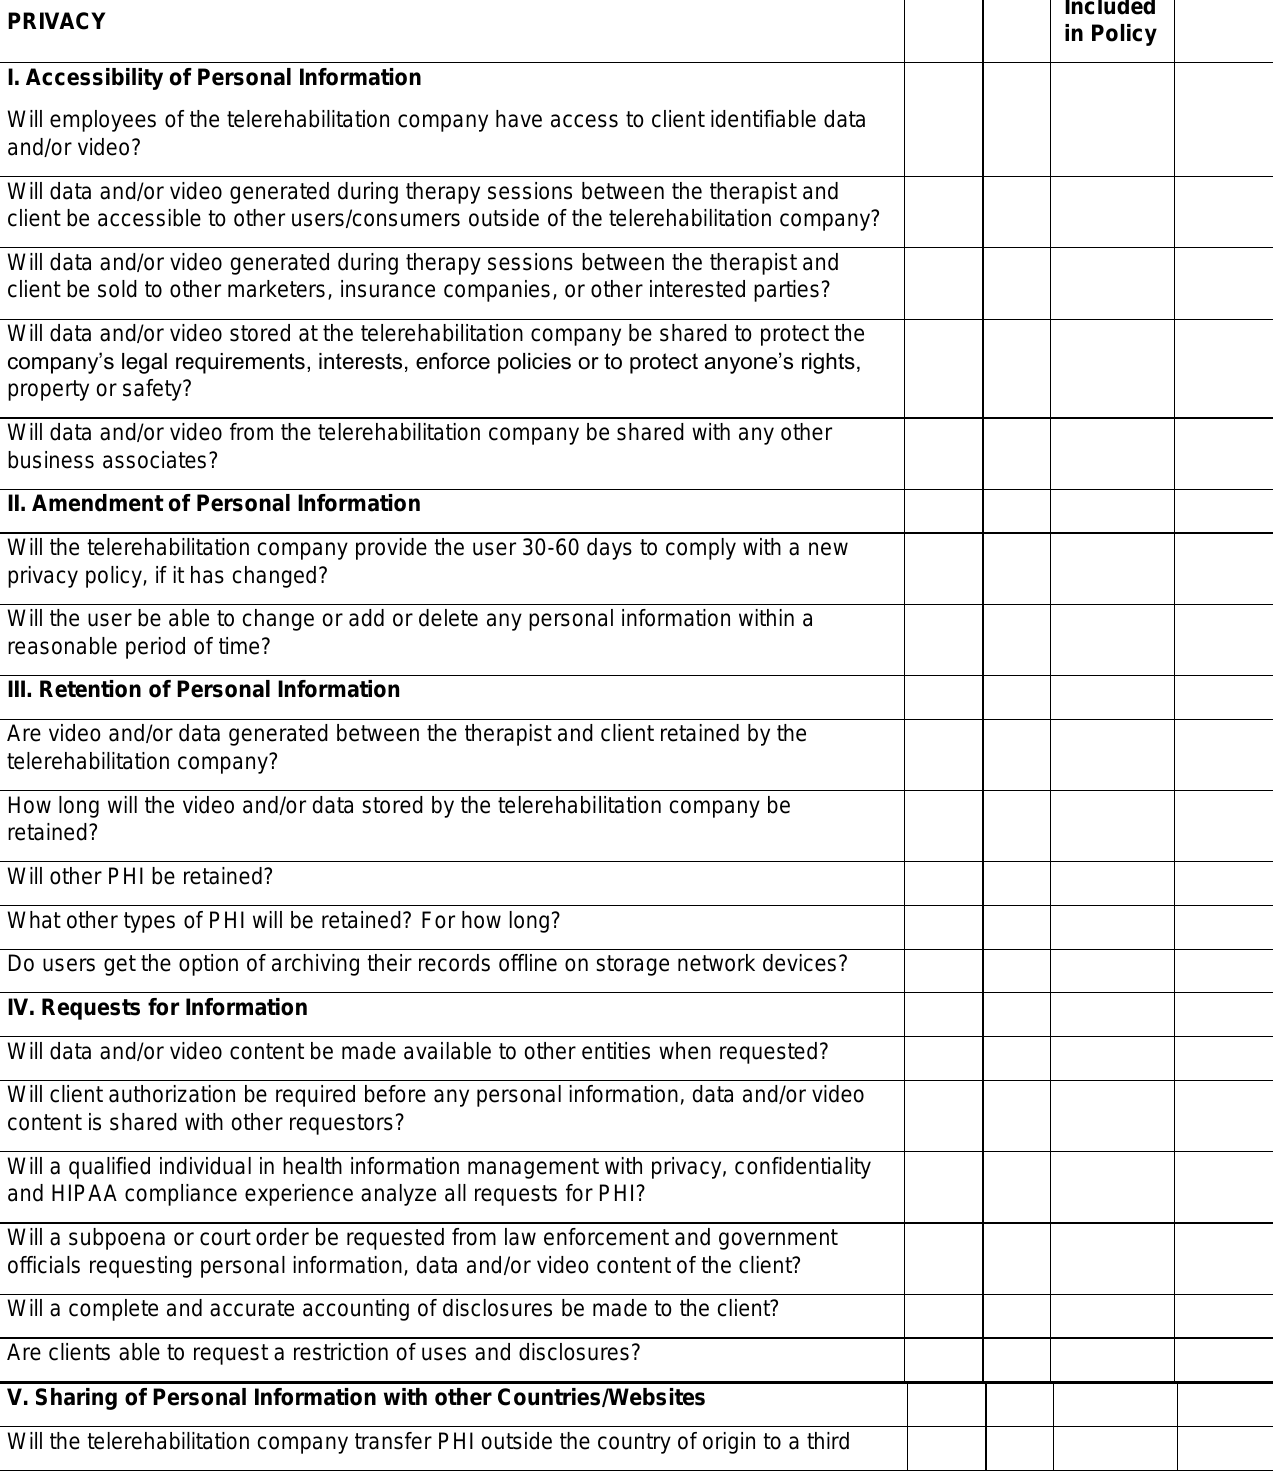
Table 1. Privacy and Security Compliance Checklist for Telerehabilitation Store and Forward Applications